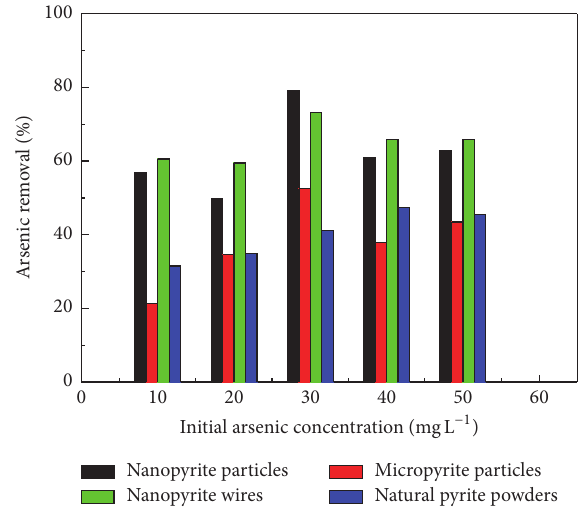
Figure 4: Effect of initial arsenic concentration on sorption of arsenic (pH = 7 , contact time = 60 min).